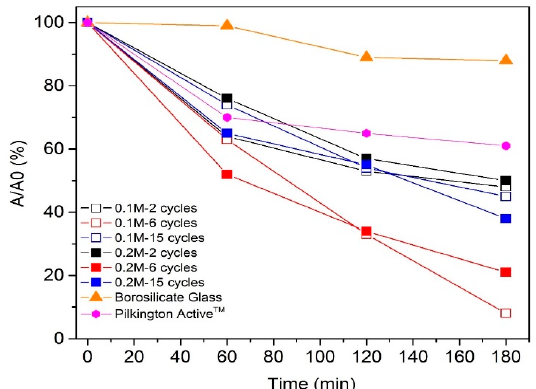
Figure 7. The degradation of stearic acid as a function of ultraviolet (UV-A) irradiation time on TiO 2 films deposited from 0.1 and 0.2 M solution applying 2, 6, and 15 spray cycles.